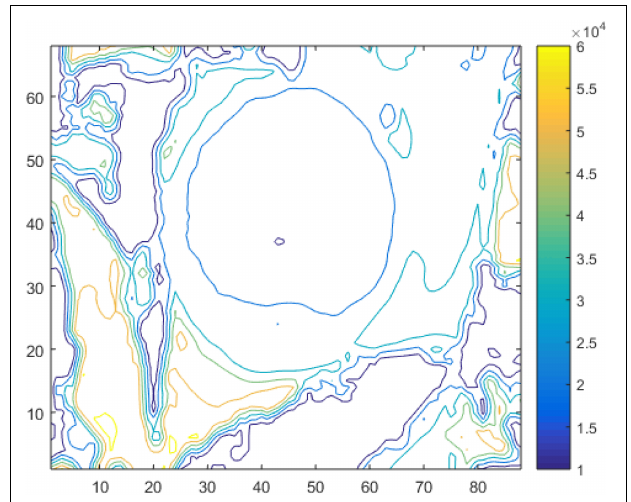
FIGURE 3 | Contours of the depth